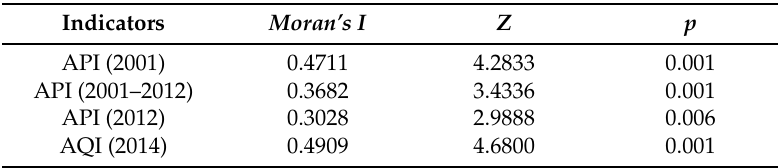
Table 3. The global spatial autocorrelation of the API and